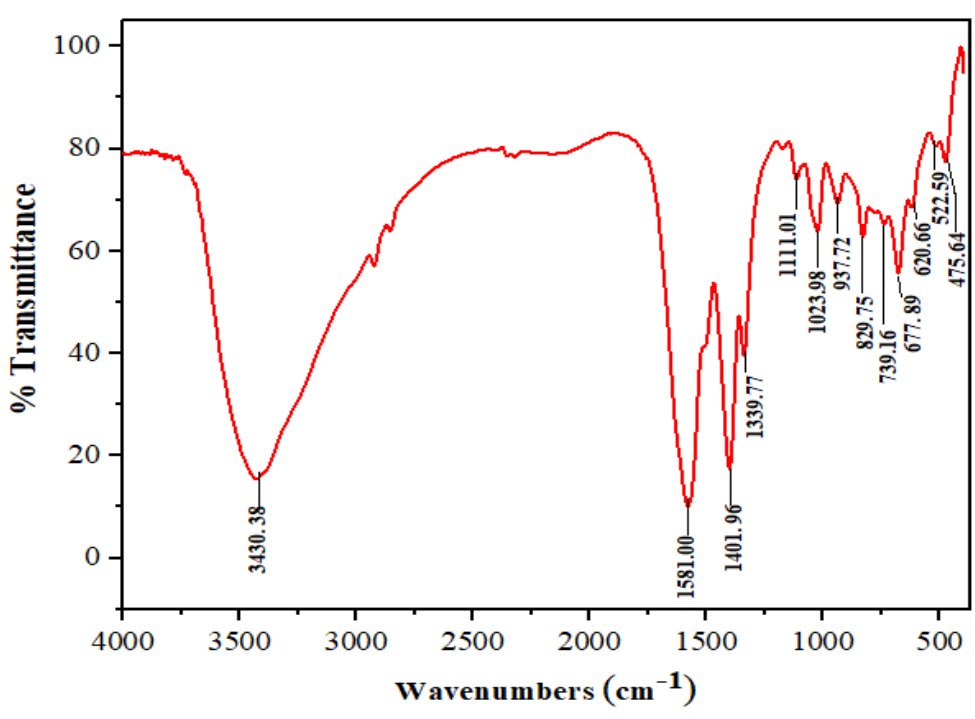
Figure 5. FTIR analysis of Mn:ZnS QDs.